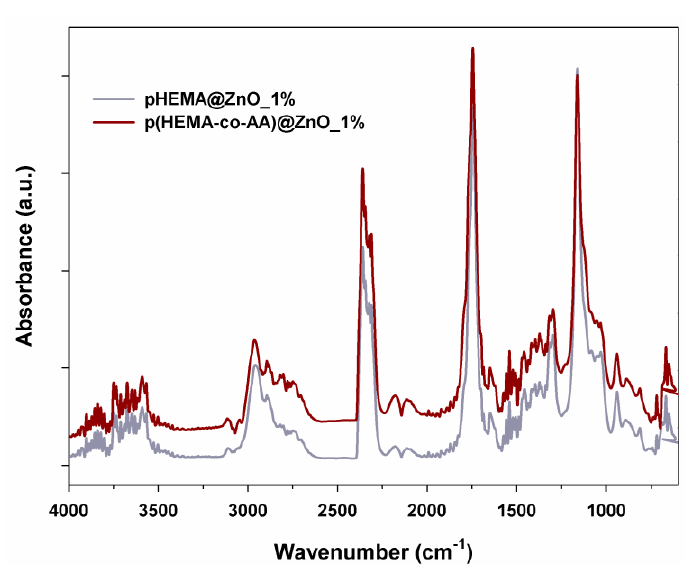
Figure 6. The 3D FTIR spectra for ( a ) polyHEMA@ZnO_0.1%; ( b ) crosslinked poly(HEMA-co-